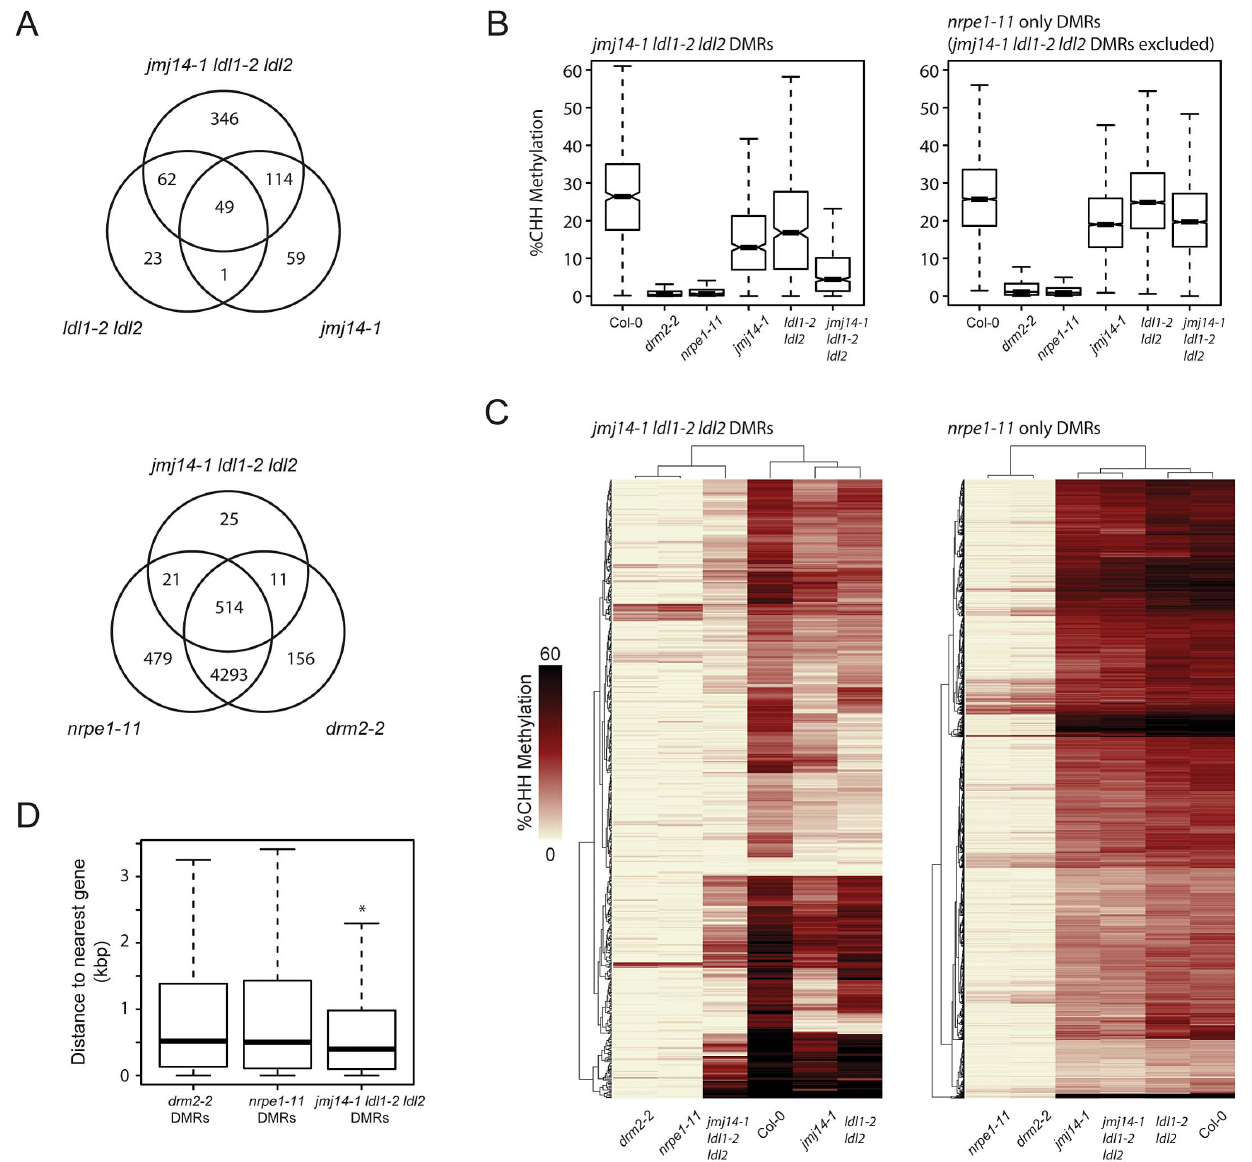
Figure 2. De novo identification of DMRs in jmj14-1ldl1-2ldl2 and nrpe1-11 mutant backgrounds. (A) Venn diagrams representing the genomic overlap of DMRs identified in each mutant background. (B) Boxplot of CHH methylation levels at DMRs of given groups. (C) Distance clustered heat map of CHH methylation levels at DMRs of listed groups. (D) Boxplot of distances between DMRs of listed mutant backgrounds and the nearest protein-coding gene. * indicates a significant difference from the drm2 and nrpe1 DMRs (P , 2.2e-14, Welch Two Sample